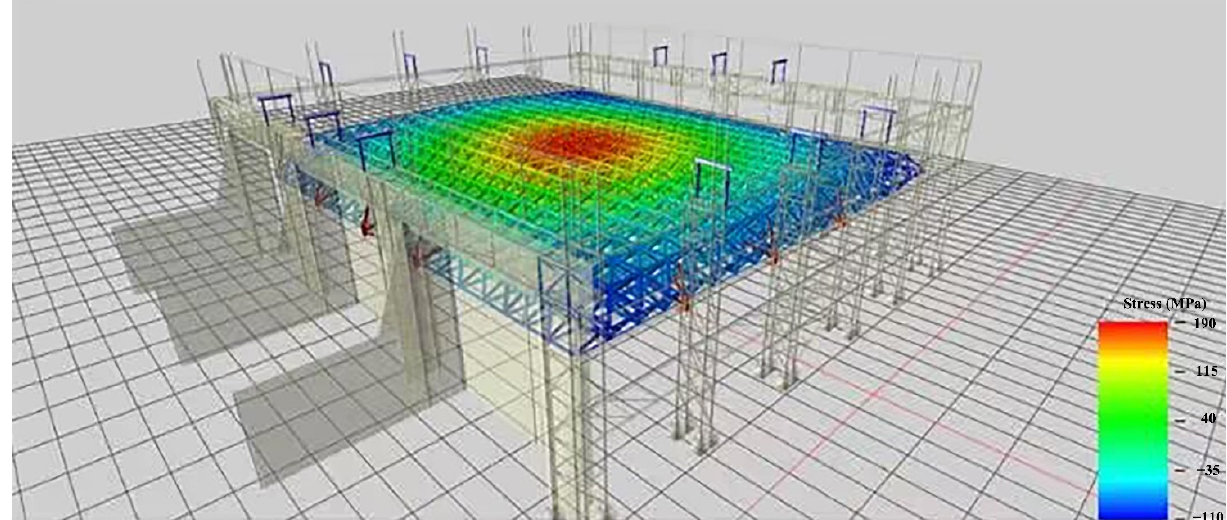
Figure 8. Monitoring data collection of an intelligent real-time analysis system.